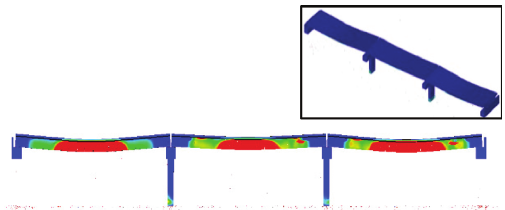
Figure 23: Principal normal strain during the time of “model A3-S-K.”